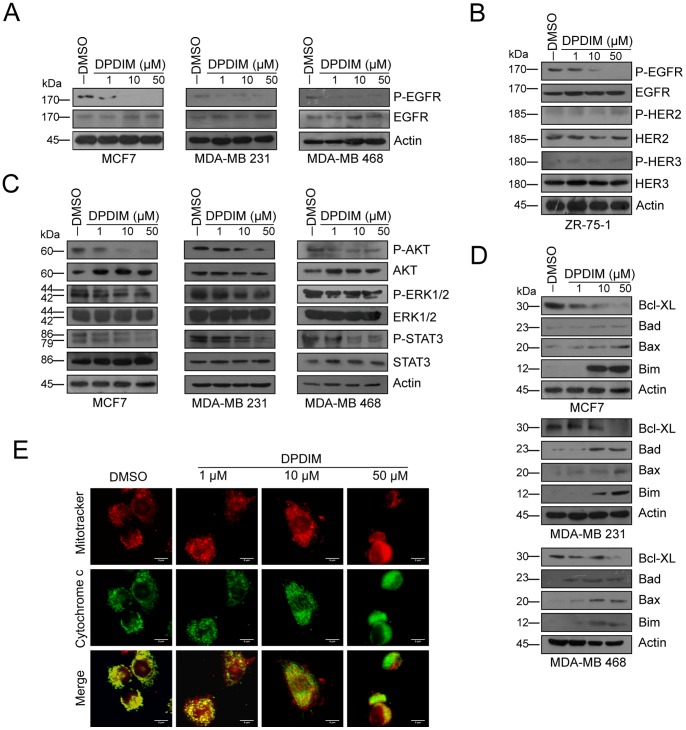
Evaluation of the inhibitory effect of DPDIM on EGFR pathway and induction of mitochondrial cytochrome c release.(A), The change of Phospho-EGFR levels were examined in MCF7, MDA-MB 231 and MDA-MB 468 cells following DPDIM treatment for 24 hr by IB. (B), Alteration in normal and activated level of EGFR, HER2 and HER3 in 24 hr DPDIM treated ZR-75-1 cells were examined by IB. (C), Whole cell lysates (WCL) were prepared from 24 hr DPDIM treated cells and immunoblotted for normal and activated forms of AKT, ERK1/2 and STAT3. (D), IB analyses of Bcl-XL, Bax, Bad and Bim in MCF7, MDA-MB 231 and MDA-MB 468 cells treated with DPDIM for 24 hr. (E), Fluorescence micrographs of vehicle control (Leftmost panel) and treated (Right panels) MCF7 cells showing Cyt c release after 24 hr DPDIM treatment. All results are representative of three independent experiments.